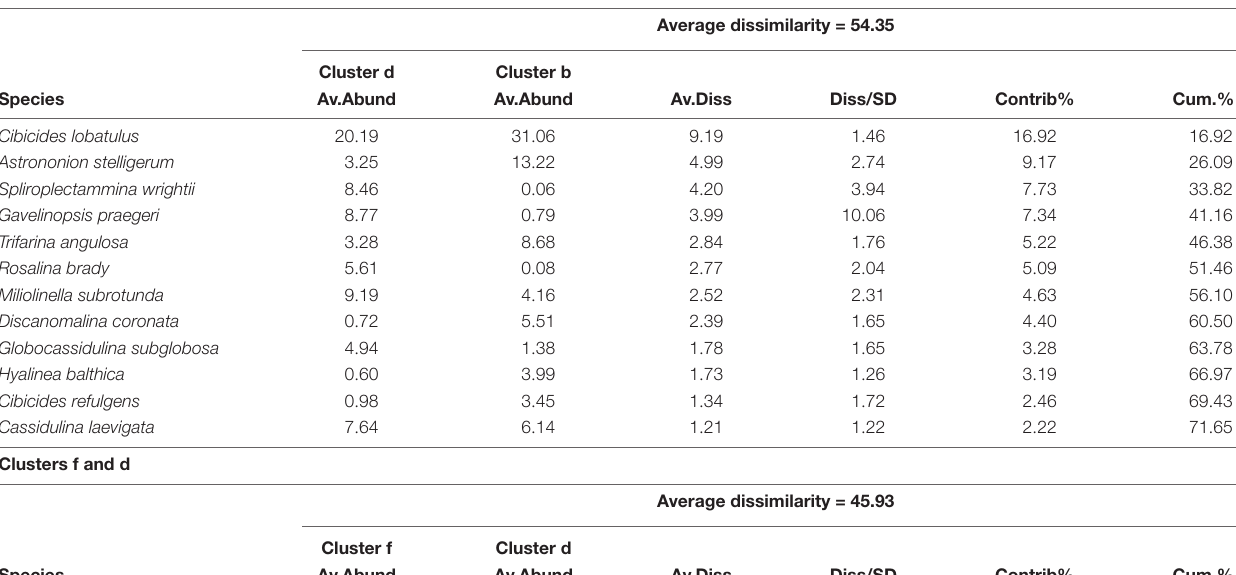
Average dissimilarity =